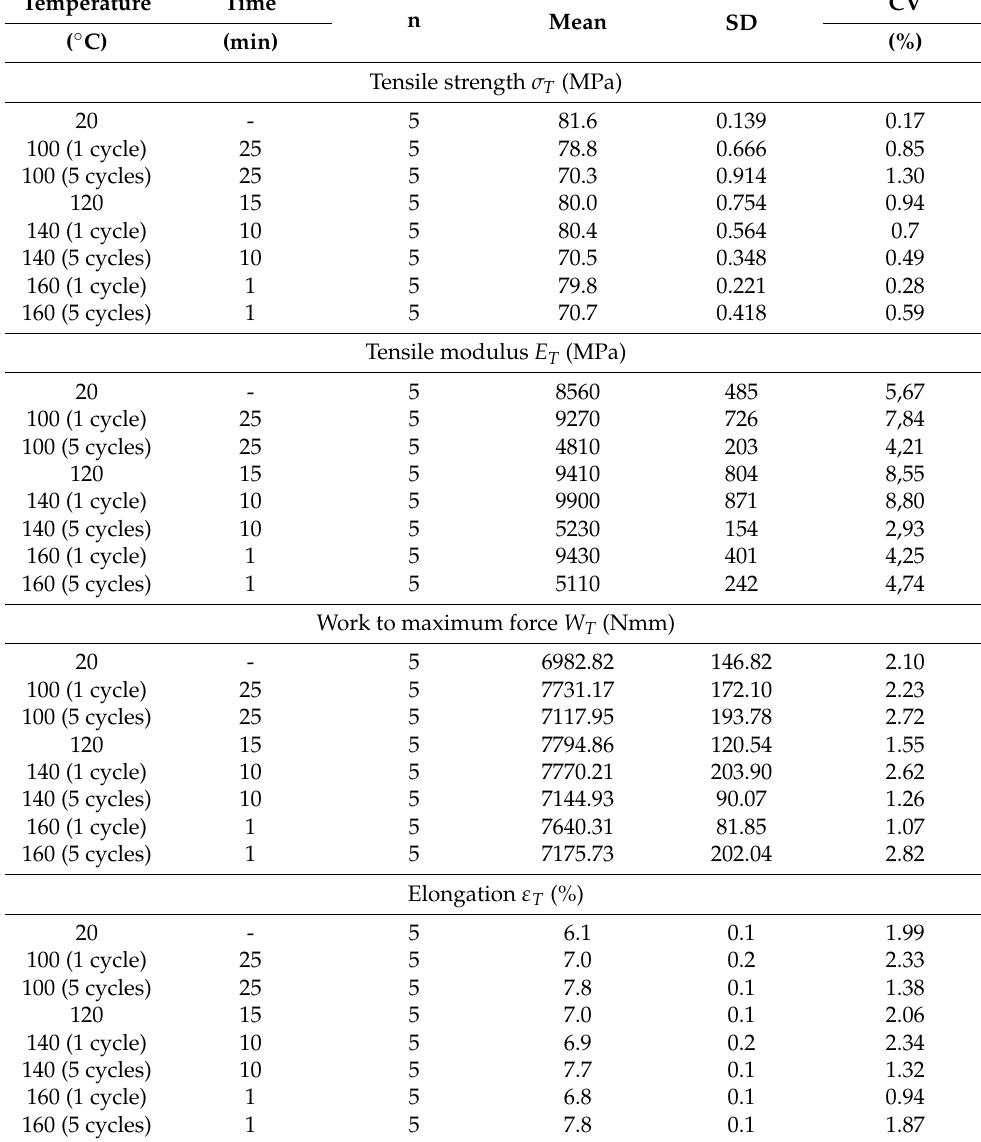
Table 3. Descriptive statistics of results of Ultramid tensile test after being treated with the hot